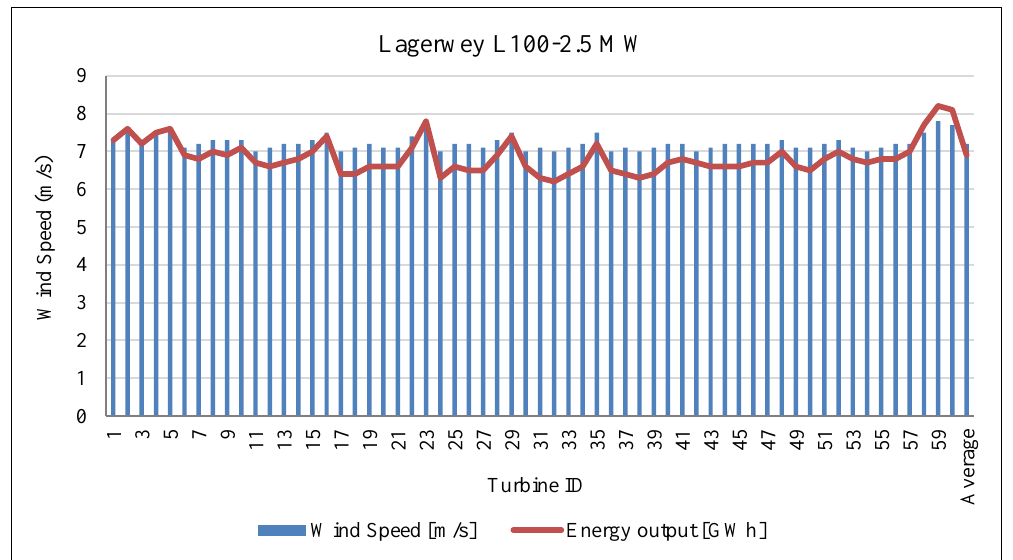
Figure 6. Energy results for configuration 3, Lagerwey L100-2.5